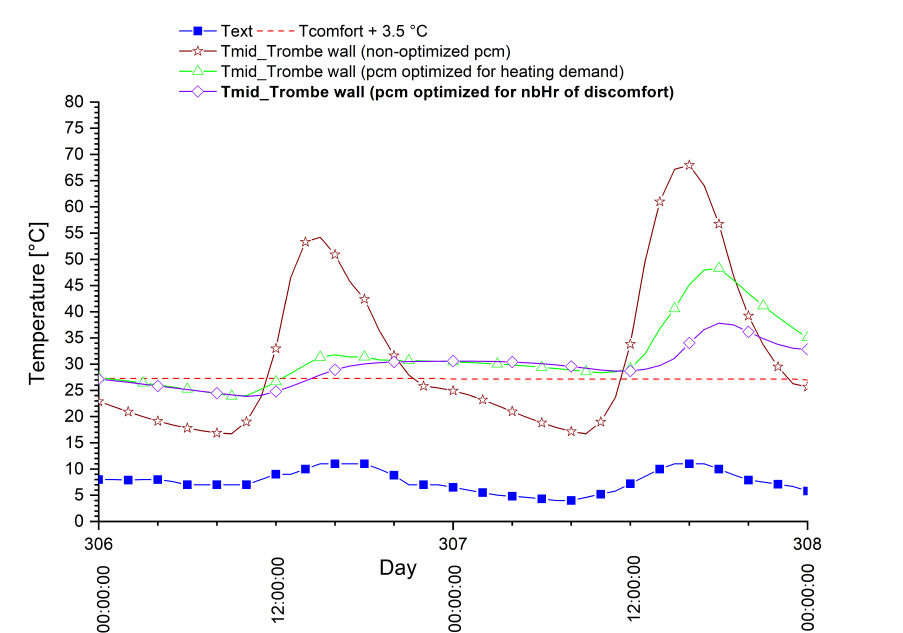
Figure 20. Temperature variations inside the bedroom. T ext and T variation in outside air temperature and the comfort setpoint temperature plus 3.5 ◦ C.